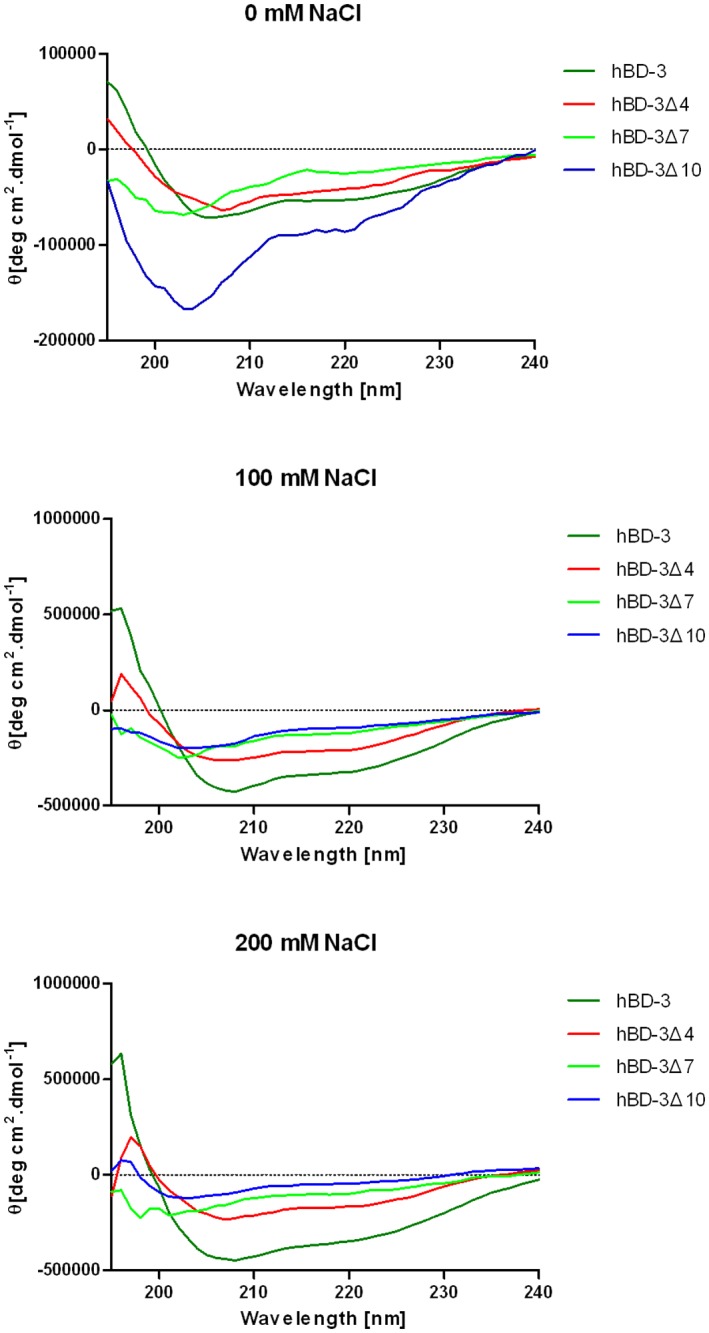
The circular dichroism spectroscopy of hBD-3, hBD-3Δ4 and hBD-3Δ7 with different NaCl concentrations.